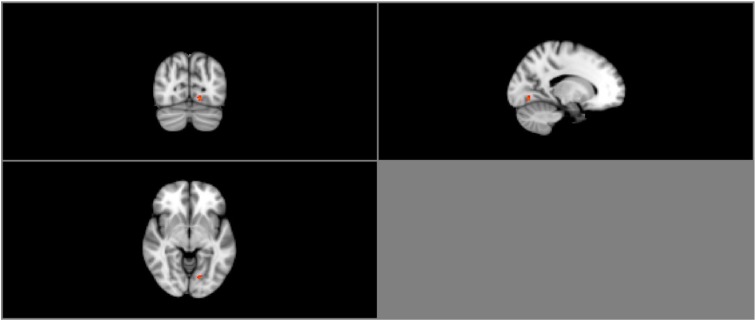
Resting-state group contrast. Highlighted areas show regions where Normal > Overweight in FEN functional connectivity (P < 0.05) during resting-state.